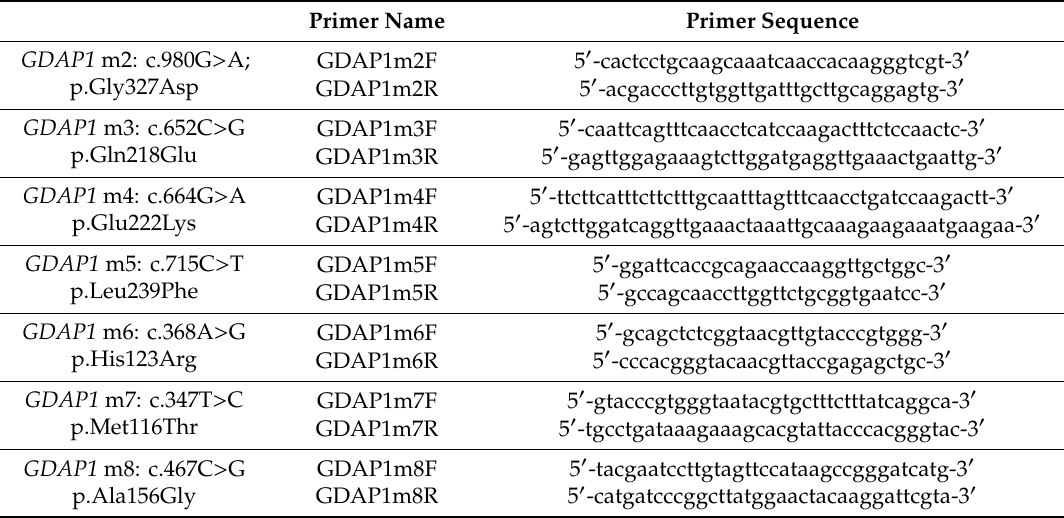
Table A1. The primer sequences for site directed